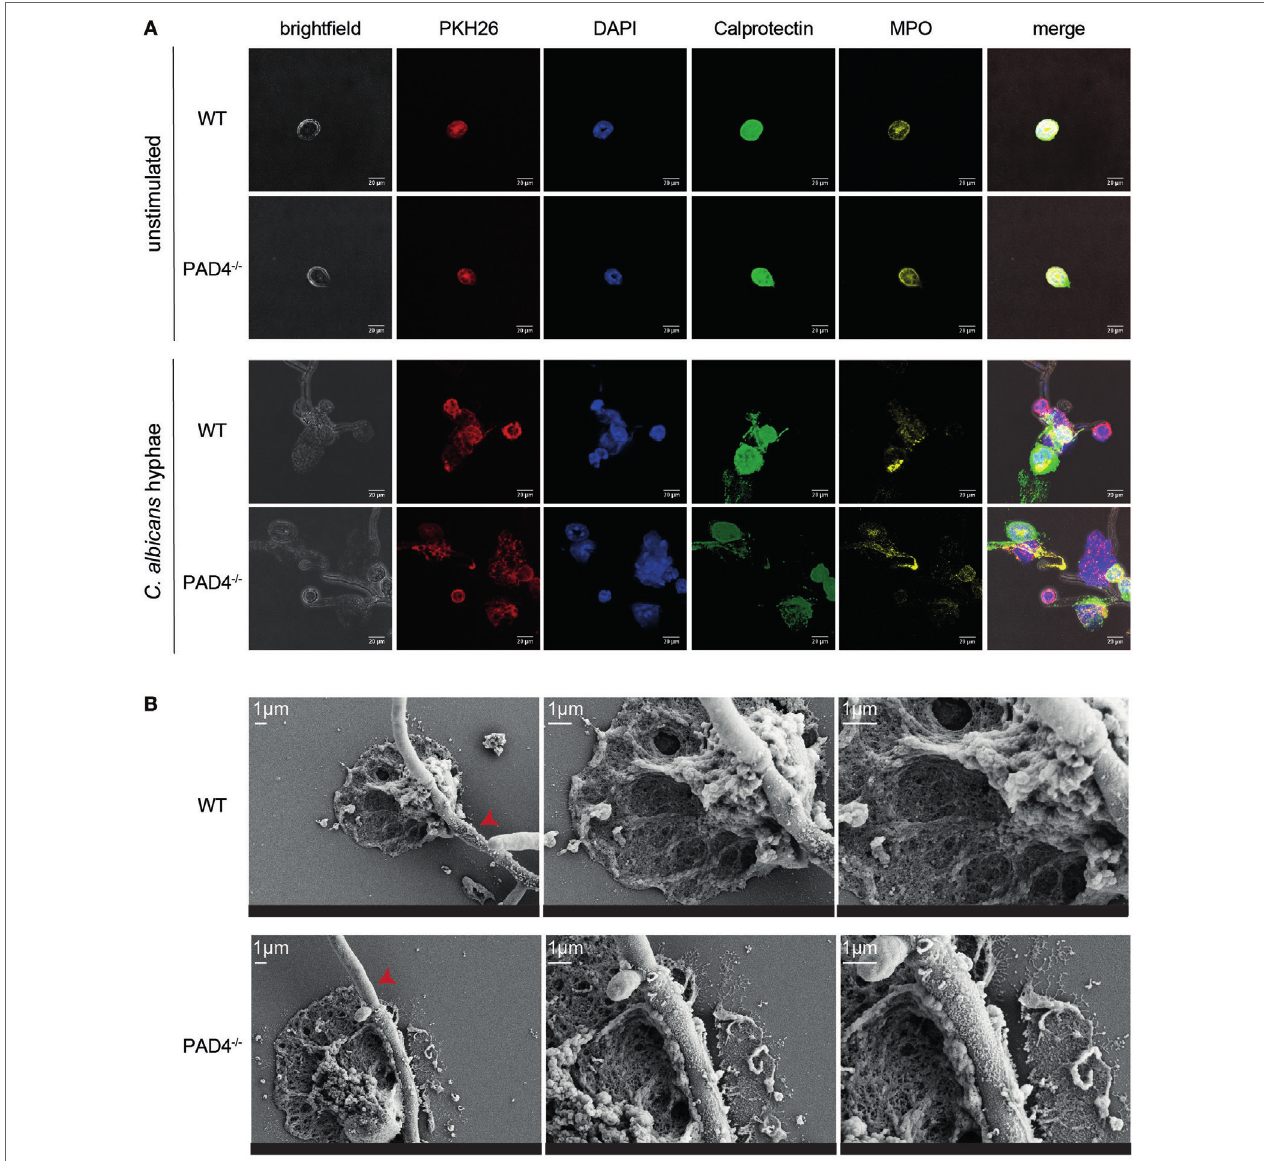
FigUre 3 | Characterization of neutrophil extracellular traps released from WT and PAD4 − / − neutrophils. (a) Bone marrow neutrophils isolated from WT and PAD4 − / − mice were stimulated for 2.5 h with Candida albicans hyphae or left unstimulated and then stained for membrane lipids (PKH26; red), DNA (DAPI; blue), calprotectin (anti-S100A8 and anti-S100A9, green), and myeloperoxidase (yellow). Images were acquired by confocal microscopy. Representative images of each group are shown. Scale bar = 20 µm. (B) Bone marrow neutrophils isolated from WT and PAD4 − / − mice were stimulated for 2.5 h with C. albicans hyphae and phorbol 12-myristate 13-acetate/ionomycin. Cells were fixed and imaged by scanning electron microscopy. Representative images of each group are shown. Scale bar = 1 µm. Red arrowheads show C. albicans